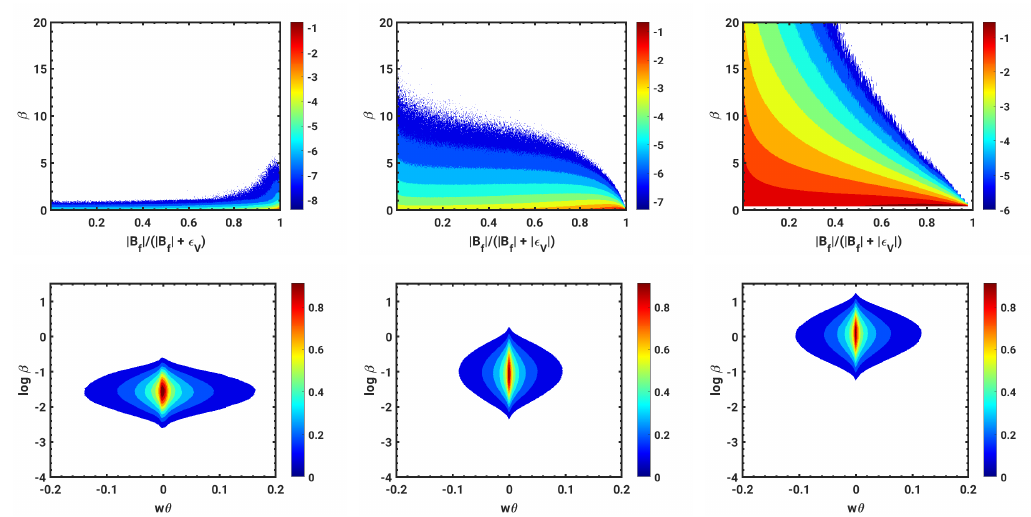
Figure 6. Point-wise efficiency of kinetic energy dissipation, β ( x ) , vs. buoyancy flux, for the three fiducial runs. Top : β is in linear coordinates and plotted against the normalized buoyancy flux B N itself normalized by the Brunt-Väisälä frequency, B f / N = w θ . Note the clear increase of β from regime I at left to regime III at